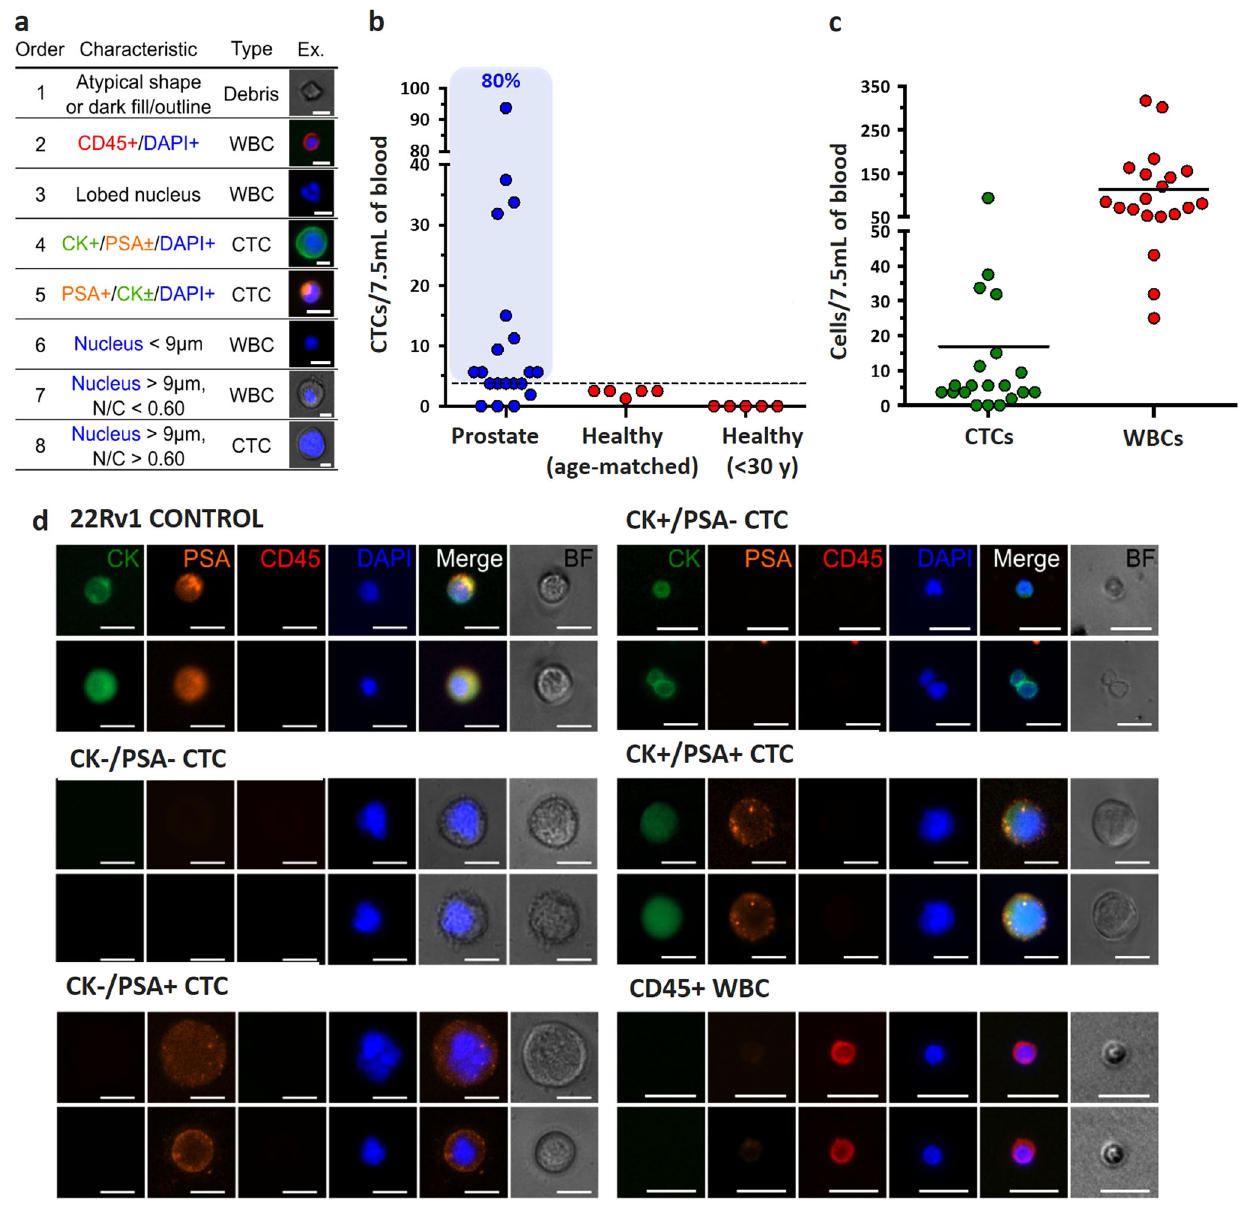
Fig. 3 Prostate CTC enumeration criteria. a Collected cells were enumerated using objective criteria based on immuno fl uorescence staining and cytomorphological characteristics, shown in the table. Each cell was assessed for each criteria in the order listed until the characteristics matched. Scale bars represent 10 µm. b The number of CTCs per 7.5 mL of blood was evaluated for our PC patient cohort ( n = 20 samples), healthy donors of same age ( n = 5), or donors younger than 30 years old ( n = 5). The dotted line represents the threshold de fi ned from the age- matched healthy donors as the mean number of CTCs + 2 SD, calculated to be 3.37 CTCs/7.5 mL. c For all patient samples, CTC and WBC numbers are represented, with 0 – 93.75 CTCs/7.5 mL and 25.00 – 316.88 WBCs/7.5 mL, respectively. d A diverse set of CTCs were collected from patients, which varied in size and displayed all combinations of CK and PSA expression. Scale bars represent 20